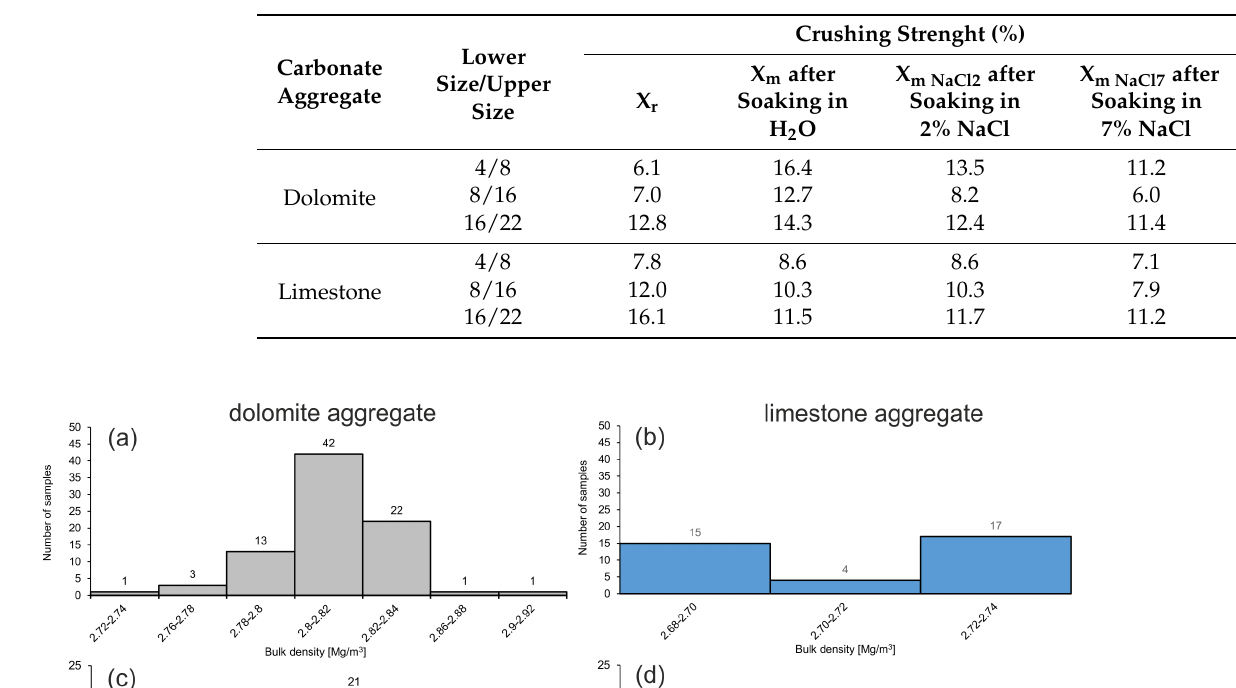
Table 2. Geotechnical parameters of dolomite and limestone aggregates. Crushing strength before and after water and NaCl adsorption.